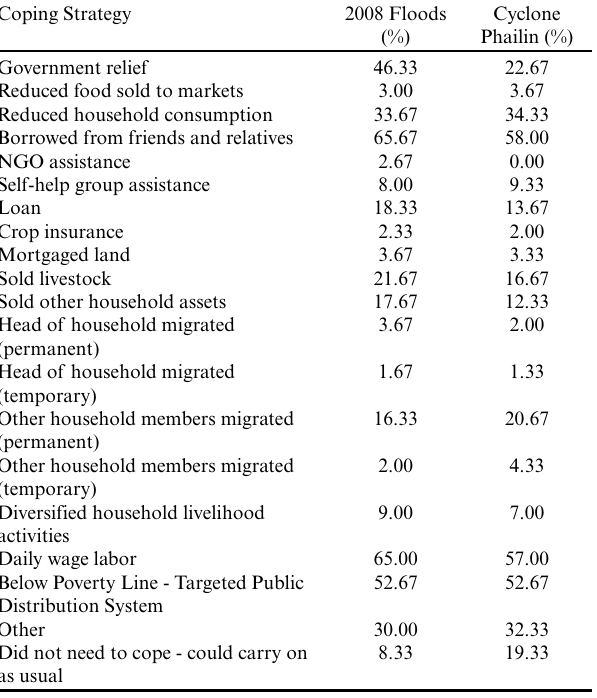
Table 5 . Coping strategies employed by households following rice crop loss after the 2008 floods and cyclone Phailin. (Each cell represented as proportion of all households [N = 300]).